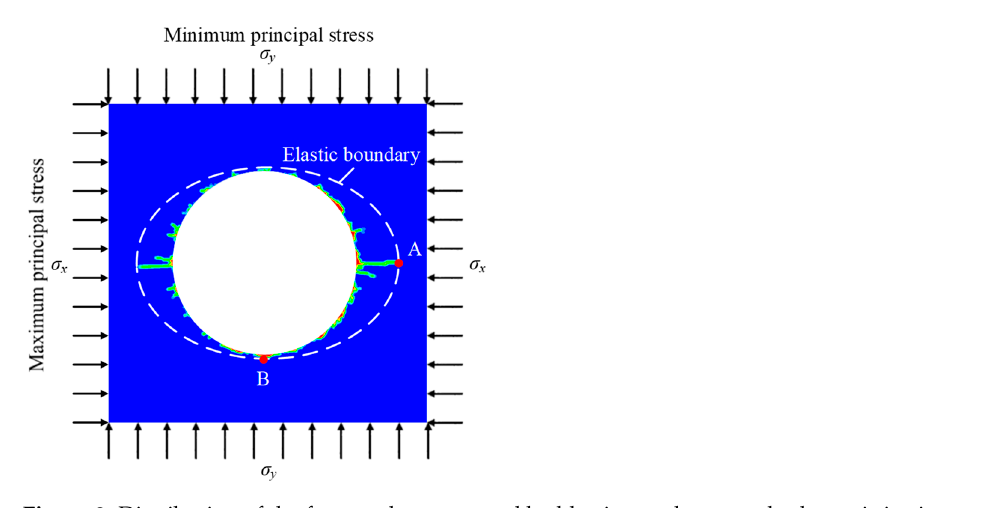
Figure 9. Distribution of the fractured zone caused by blasting under a non-hydrostatic in situ stress condition σ x = 3 σ y = 30 MPa.